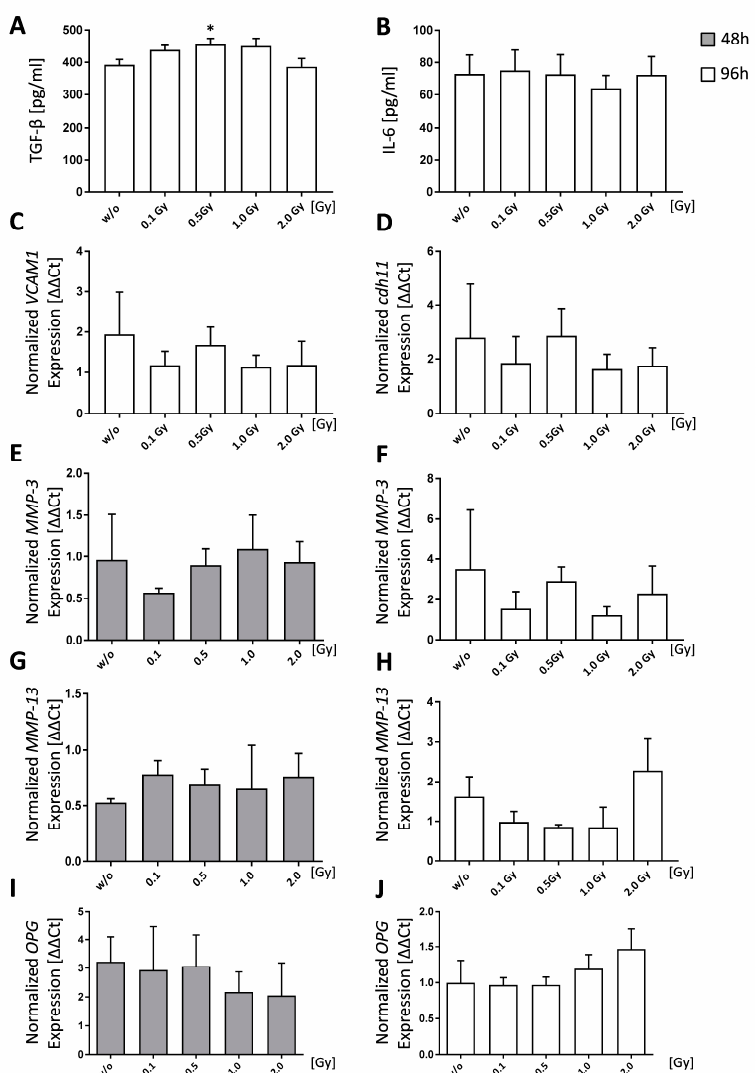
Figure 2. Low doses of ionizing radiation show only a minor impact on cytokine release by healthy fibroblast-like synoviocytes (FLS) as well as on molecules involved in cartilage and bone destruction. Healthy FLS cultures obtained from C57Bl/6 mice were seeded and analyzed 48 h (grey bars) or 96 h (white bars) after the treatment with low, intermediate, and high doses of ionizing radiation. ( A , B ) show cytokine levels for TGF- β and IL-6, as determined via ELISA. ( C – J ) show quantitative PCR (qPCR) data after phenol-chloroform RNA extraction with subsequent gene expression analysis via SYBR green qPCR analyses. Measurements were normalized using the housekeeper genes RPS18 , GAPDH , and ACTB . Shown is the data of three FLS cell pools examined in three independent experiments, each being performed in triplicates. Data is presented as mean ± SEM and analyzed by two-tailed Mann-Whitney-U test in comparison to untreated controls. (* p < 0.05).